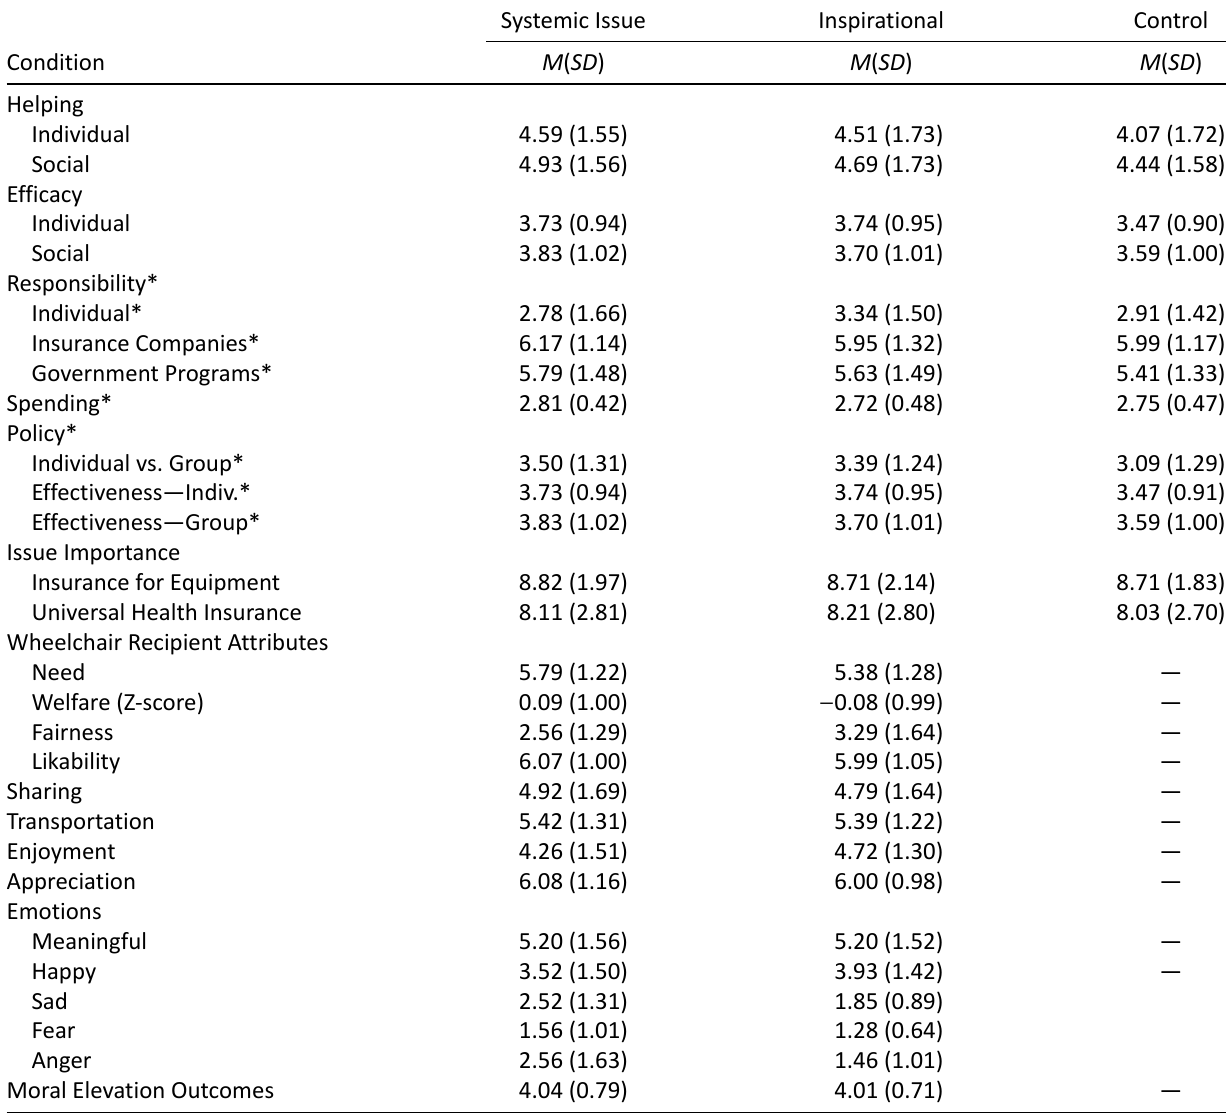
Table 1. Variable means and standard deviations by